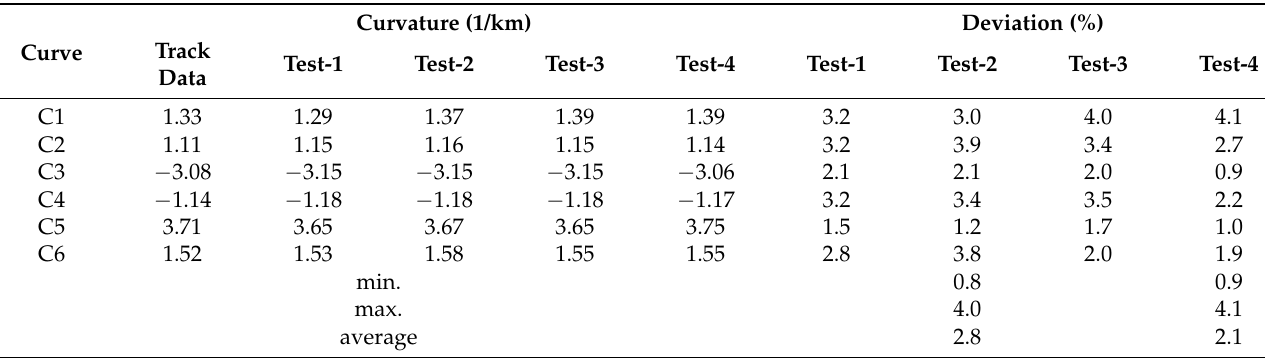
Figure 16. Curvature test results based on running speed. Table 4. Curvature measurement